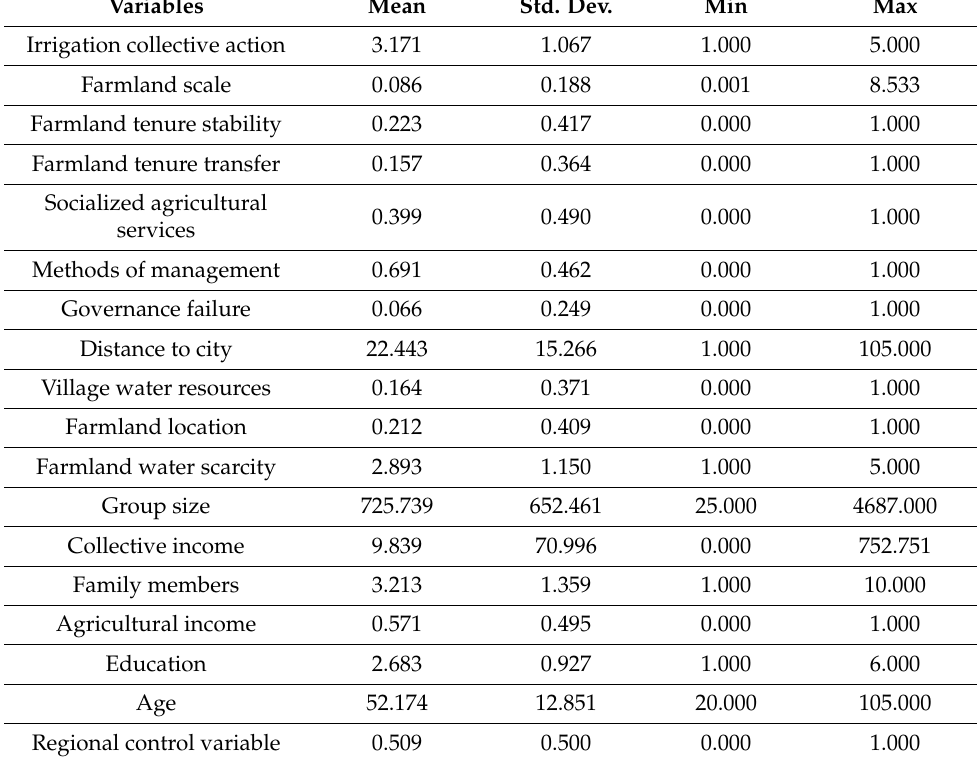
Table 2. Results of descriptive